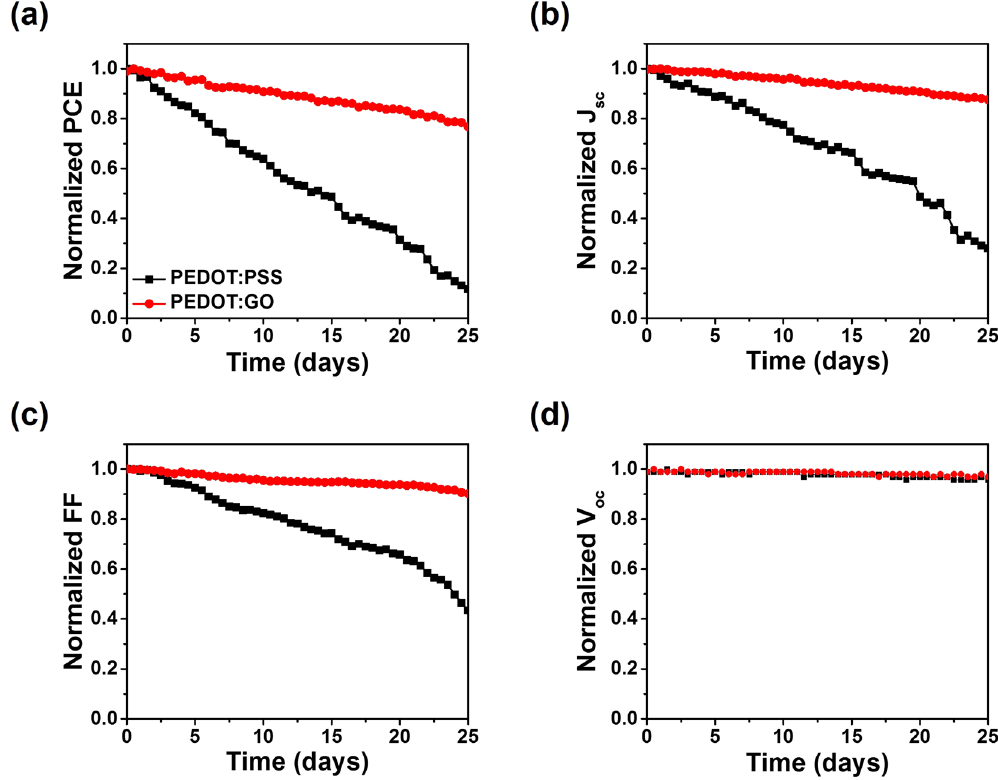
Figure 5. Stability characteristics of the perovskite solar cells with PEDOT:PSS and PEDOT:GO composite films under ambient air conditions: ( a ) Normalized PCE, ( b ) Normalized J sc , ( c ) Normalized FF , and ( d ) Normalized V oc ,